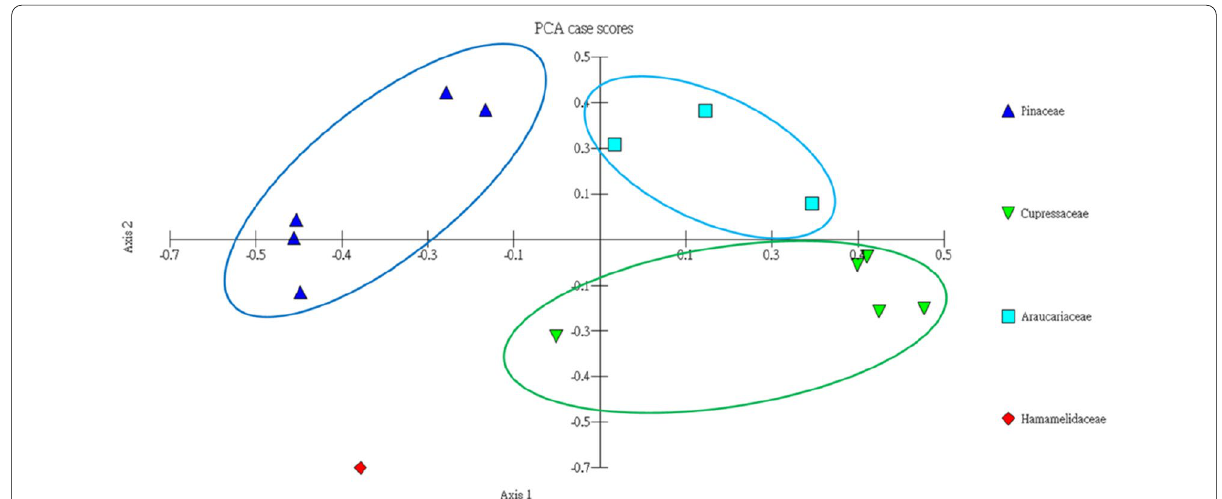
Fig. 7 PCA score plot based on signal regions of HSQC and grouped by